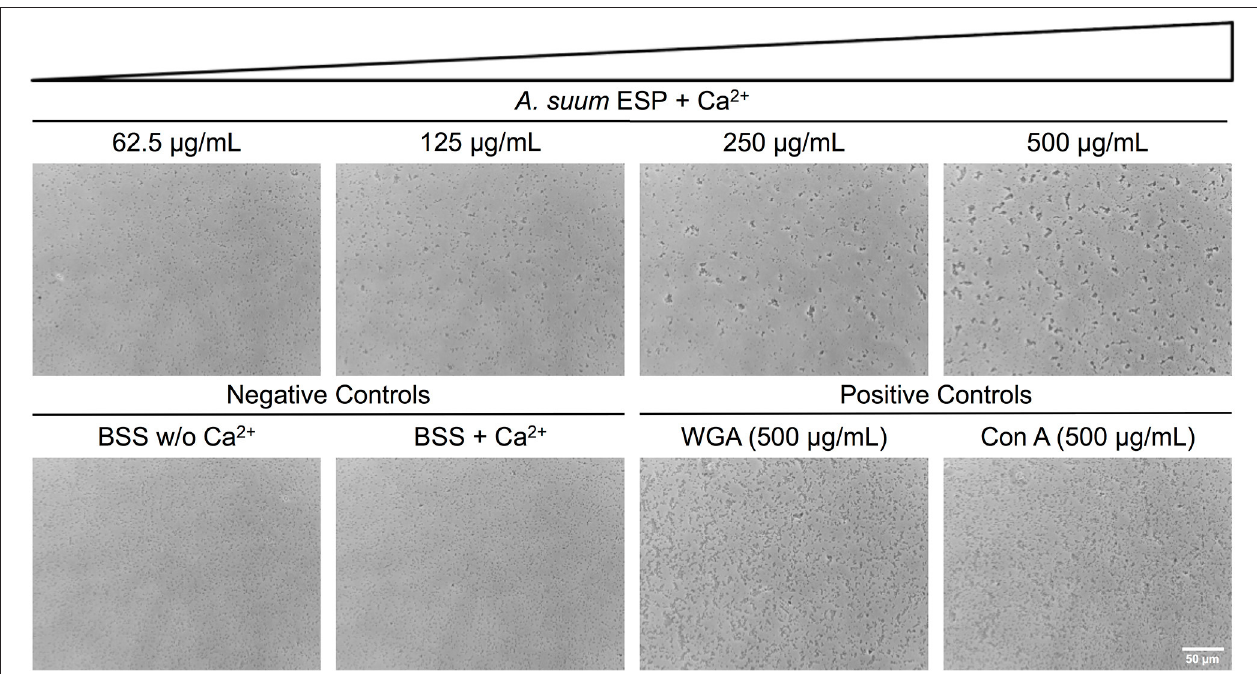
FIGURE 4 | Ascaris suum excretory/secretory products cause bacterial agglutination. Bacterial agglutination in the presence of adult A. suum ESP and 10mM CaCl 2 . Representative images of agglutination of E. coli IMT19224 with serial dilutions (1/2 factor) of A. suum ESP. Controls of agglutination include adult worm media (BSS) with and without CaCl 2 as well as the C-type lectins wheat germ agglutinin (WGA) and concanavalin A (Con A). Bacteria visualized at 400X